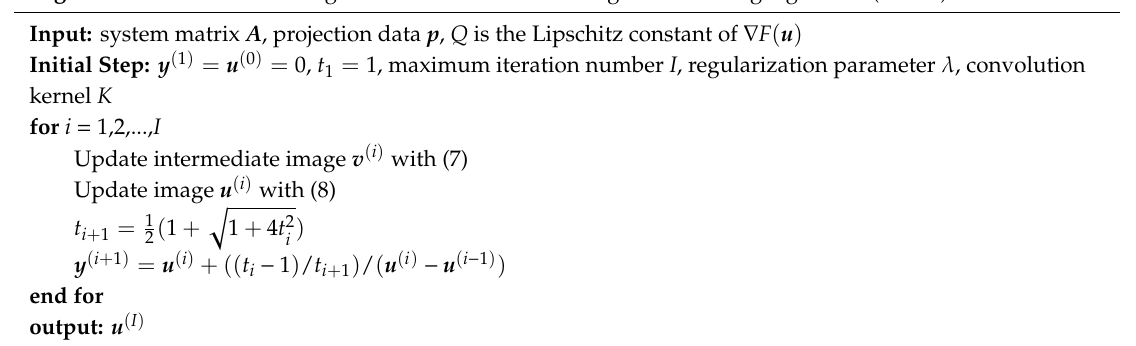
Algorithm 1 Workflow of the general fast iterative shrinkage thresholding algorithm